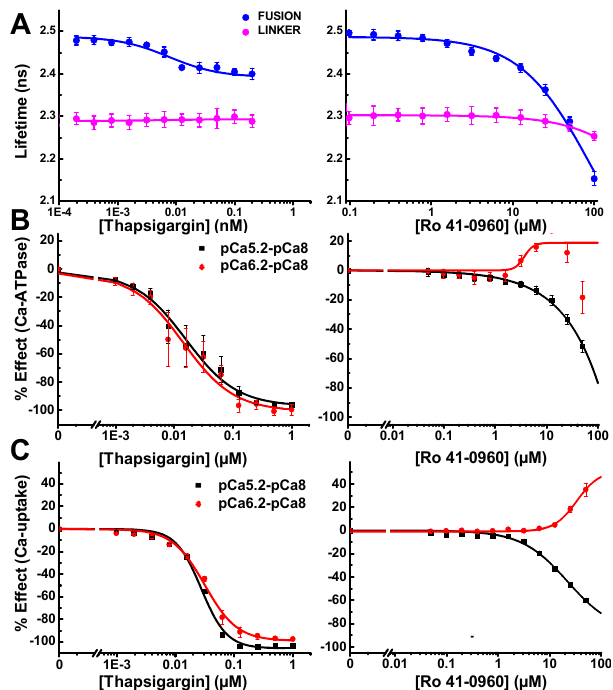
Figure 5. Concentration-response curve (CRC) analysis of LOPAC FRET Hits thapsigargin (left) and Ro 41-0960 (right). ( A ) FLT CRCs, using the fusion and linker biosensors, as indicated. ( B ) SERCA2a Ca-ATPase assays CRCs at [Ca 2+ ] corresponding to maximal activity (pCa 5.2, black), intermediate (pCa 6.2, red). Basal activity (pCa8) was subtracted from each. ( C ) SERCA2a calcium-uptake monitored at pCa 6.2 and 5.2 using the Ca-sensitive dye Fluo-4 fluorescence. Each experiment was performed in duplicate (Ca-ATPase) or triplicate (Ca-uptake); error bars indicate SEM (n = 2 or 3). Curves generated using Hill